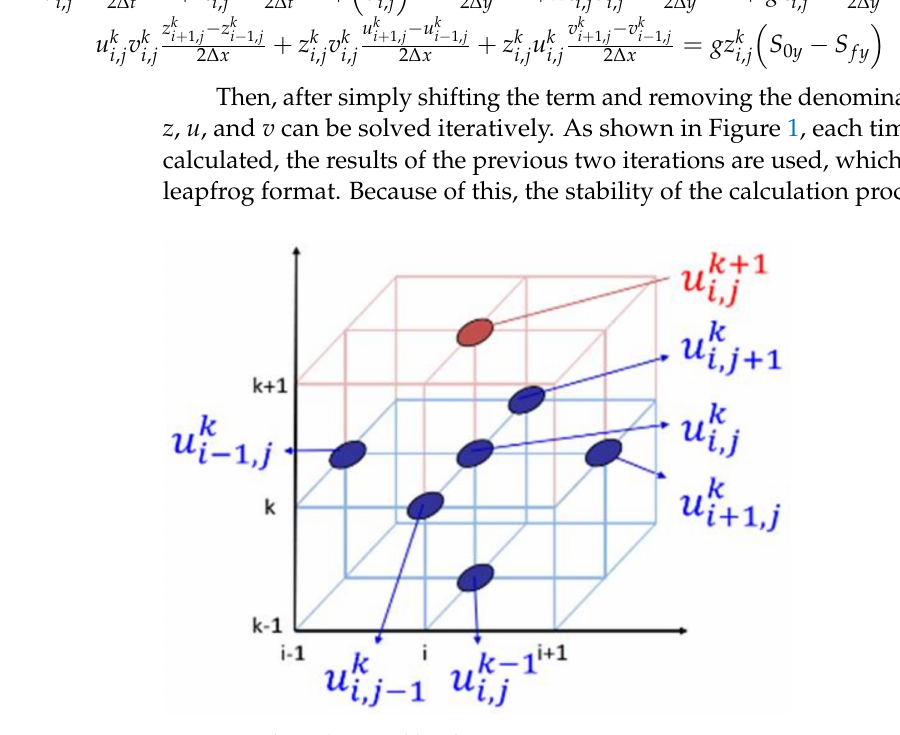
Figure 1. The value used by the iterative